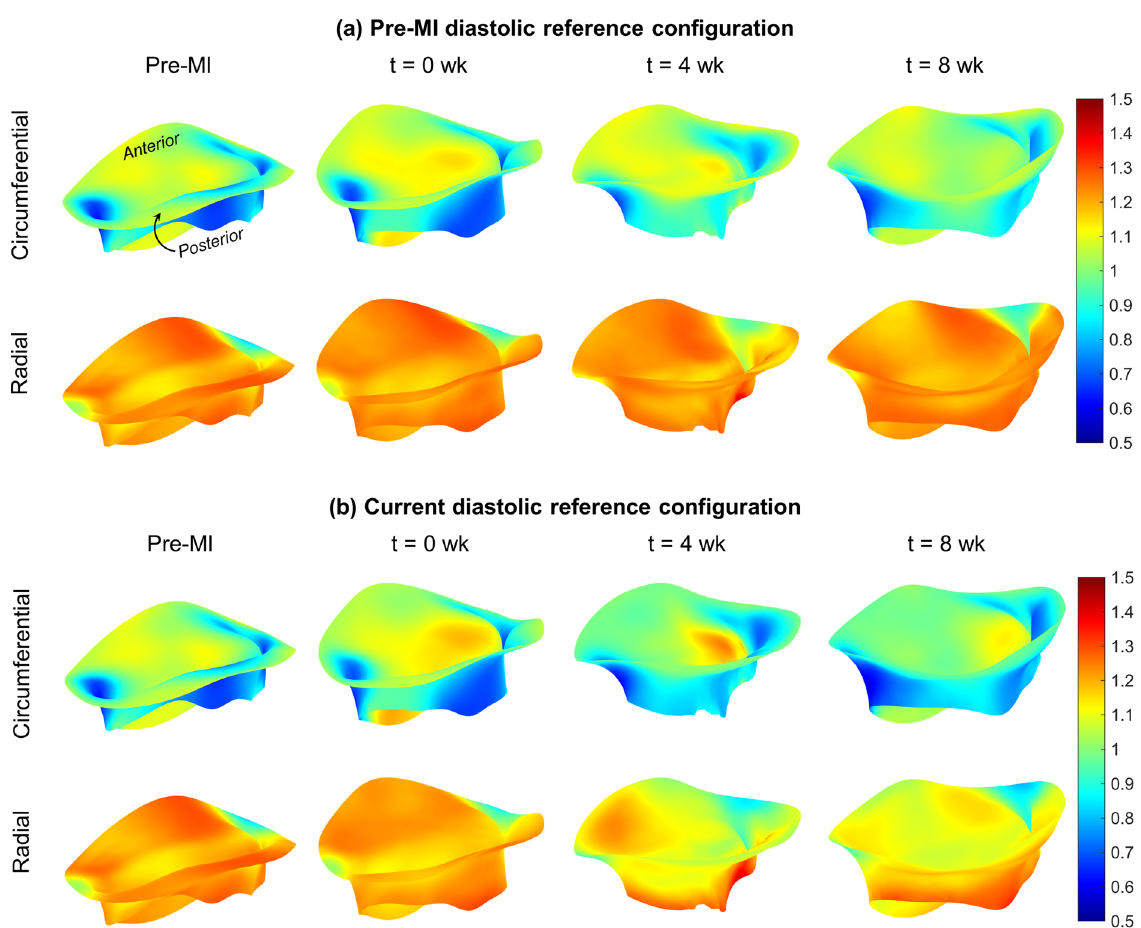
Figure 4. Average systolic directional stretch fields over time, referenced to ( a ) the pre-MI diastolic configuration and ( b ) the current time point’s diastolic configuration. The results in ( a ) show negligible changes in both directions over time, suggesting that the fibre recruitment behaviour of the leaflet tissue remains largely the same post-MI in an absolute sense. The results in ( b ) show that the range of stretch experienced by the leaflets during the cardiac cycle is substantially decreased over time, specifically in the radial direction. This decrease can be attributed to the pre-stretch already experienced by the leaflets in diastole, which consumes much of the tissue’s overall extensibility. See Discussion for further